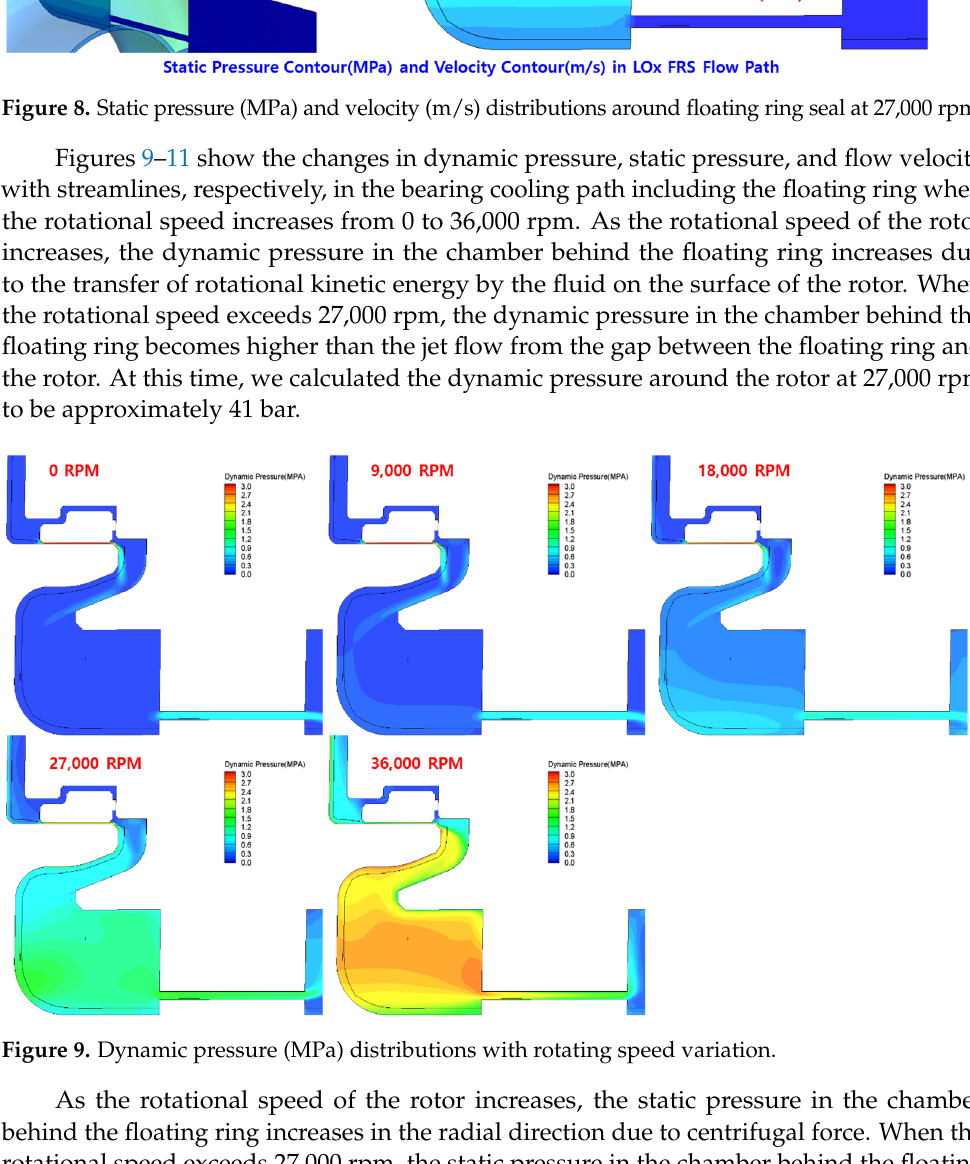
Figure 8. Static pressure (MPa) and velocity (m/s) distributions around floating ring seal at 27,000 rpm.